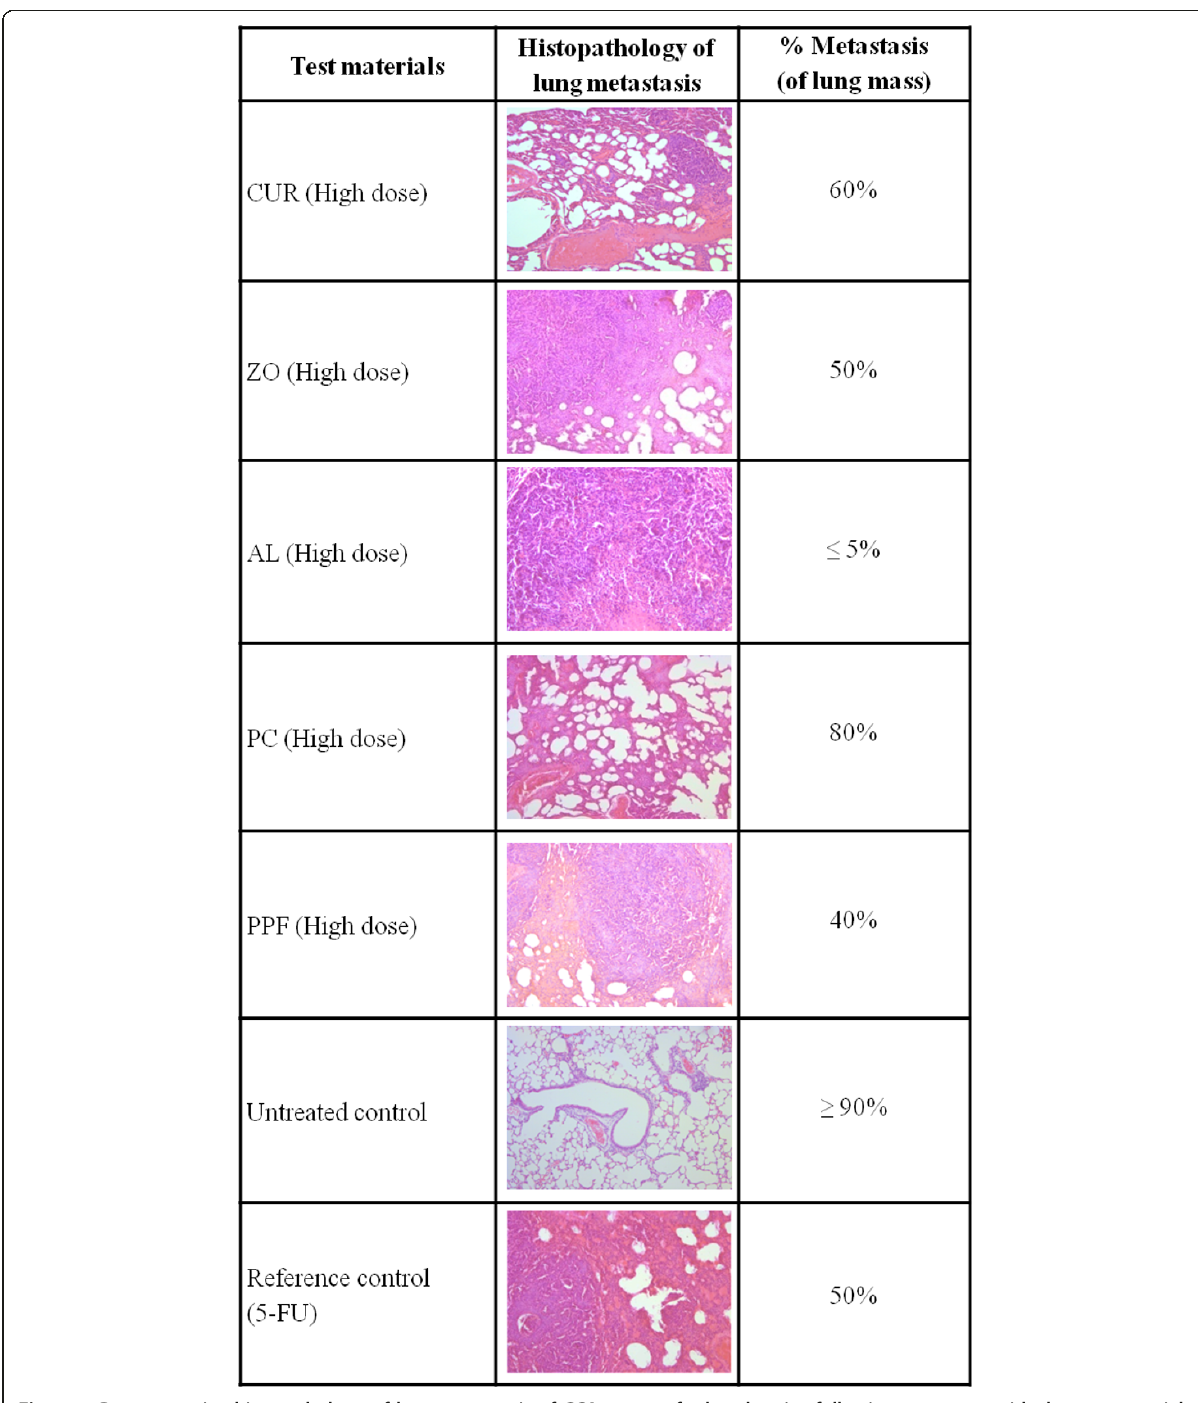
LOX in a dose-dependent manner. The latter in turn, inhibits the synthesis of leukotrienes from both COX-1 and COX-2 and LOX, respectively [12]. ZO has also